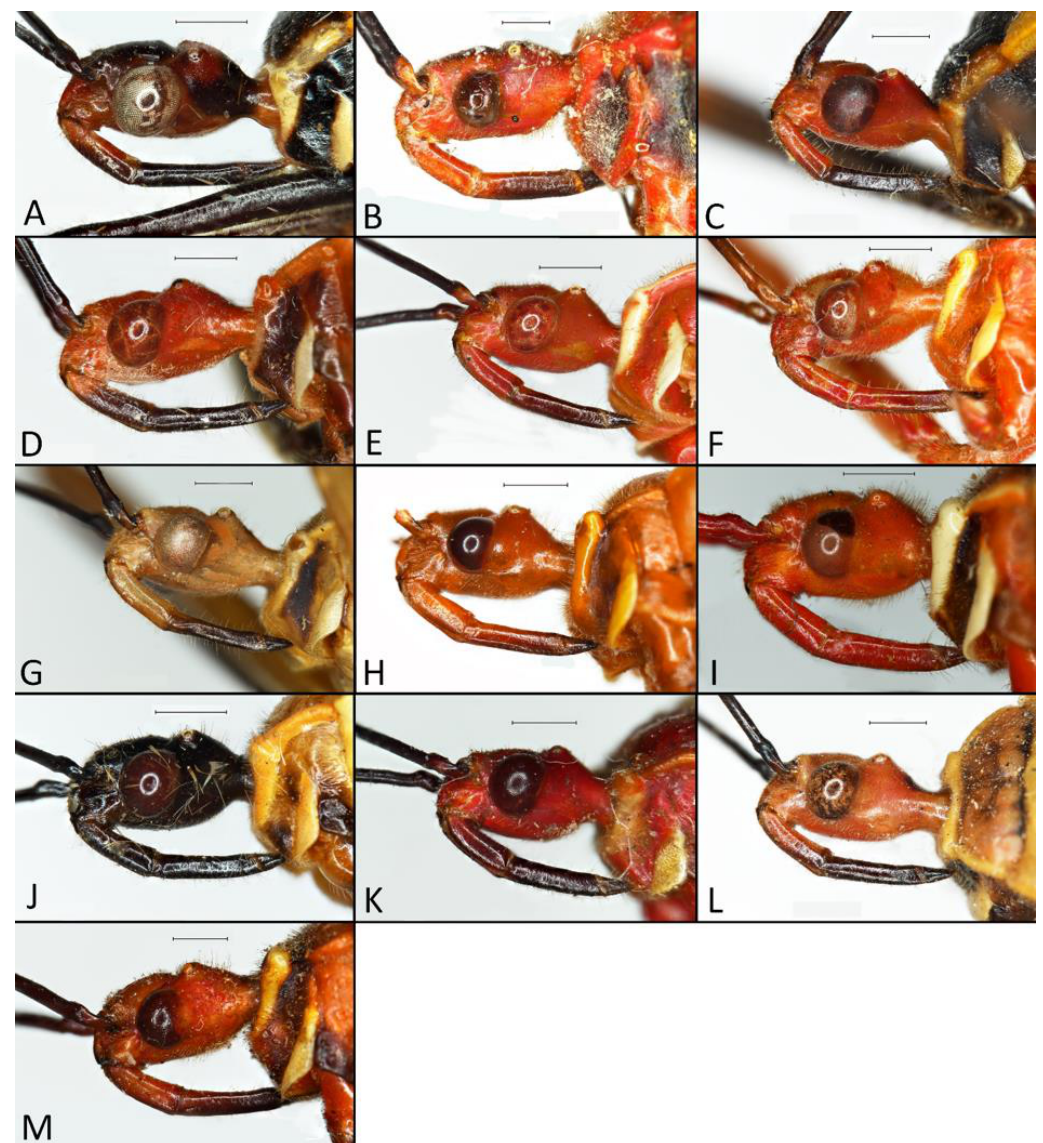
Figure 6. Head in lateral view: ( A ) Phonoctonus bifasciatus Villiers, 1948; ( B ) P. caesar Haglund, 1895; ( C ) P. elegans Varela, 1904; ( D ) P. fairmairei Villiers, 1948; ( E ) P. fasciatus (Beauvois, 1805); ( F ) P. grandis Signoret, 1860; ( G ) P. immitis Stål, 1865; ( H ) P. luridus Miller, 1950; ( I ) P. lutescens (Guérin-Méneville & Percheron, 1834); ( J ) P. nigrofasciatus Stål, 1855; ( K ) P. picta Schouteden, 1932; ( L ) P. picturatus Fairmaire, 1858; and ( M ) P. principalis Gerstaecker, 1892. Scale = 1 mm.